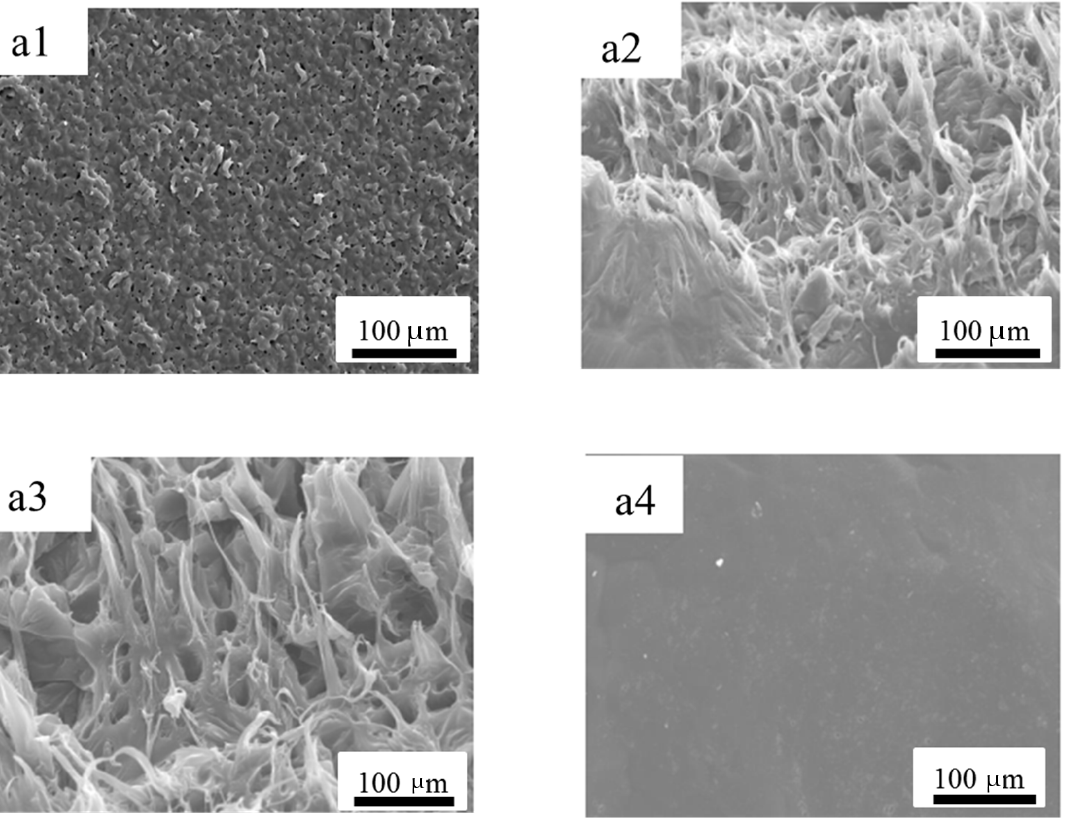
Figure 5. SEM images of the original PCL degradable mulching film ( a1 ), and after it is degraded in NaOH ( a2 ), HCl ( a3 ), and deionized water ( a4 ) for 30 days.